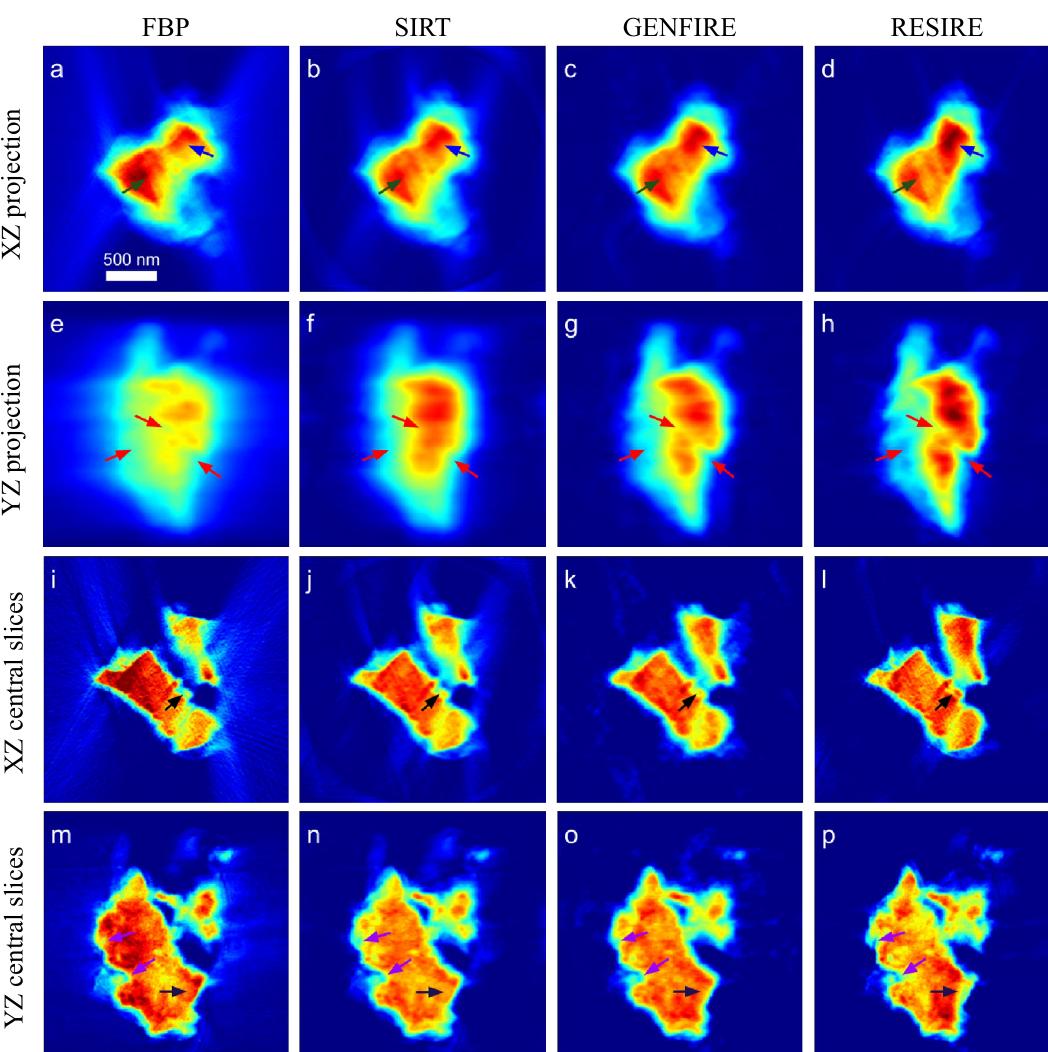
Figure 3. 3D reconstruction of an aragonite coral sample. XZ and YZ projections of the FBP ( a, e ), SIRT ( b, f ), GENFIRE ( c, g ) and RESIRE ( d, h ) reconstructions, respectively. 30-nm-thick central slices of the FBP ( i, m ), SIRT ( j, n ), GENFIRE ( k, o ) and RESIRE( l, p ) reconstructions in the XZ and YZ planes, respectively. The arrows show features that are better reconstructed by RESIRE than by the other three methods. The arrows show that RESIRE produces a reconstruction with less peripheral noise, more reduced missing wedge effects, and sharper fine features than FBP, SIRT and